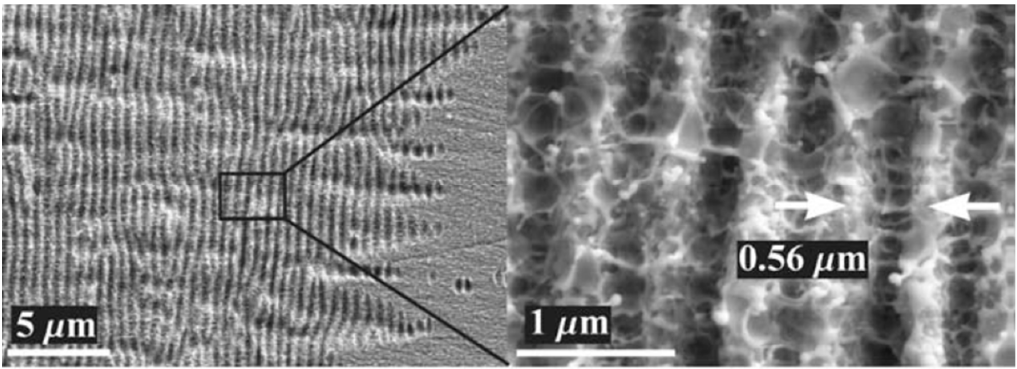
Figure 5. Detailed pictures of LIPPS on shows that LSFL generated by ultrafast laser radiation are densely covered by nanostructures (reprinted from [22] by permission from Springer, copyright 2007).